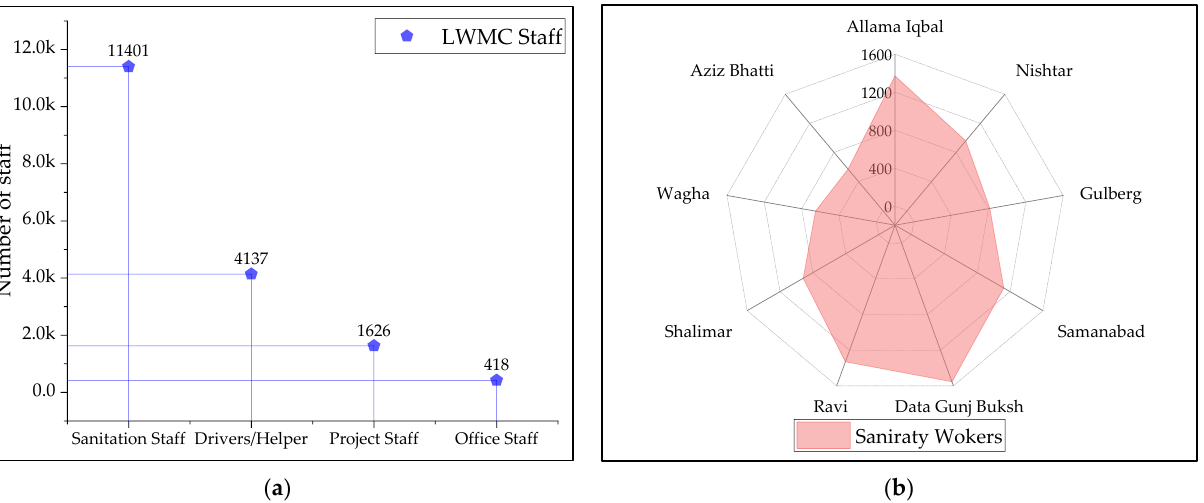
Figure 17. Staff deployed to perform operational work [98]: ( a ) Operational staff deployed in field; ( b ) Deployment of sanitary workers to perform manual sweeping and waste collection services .